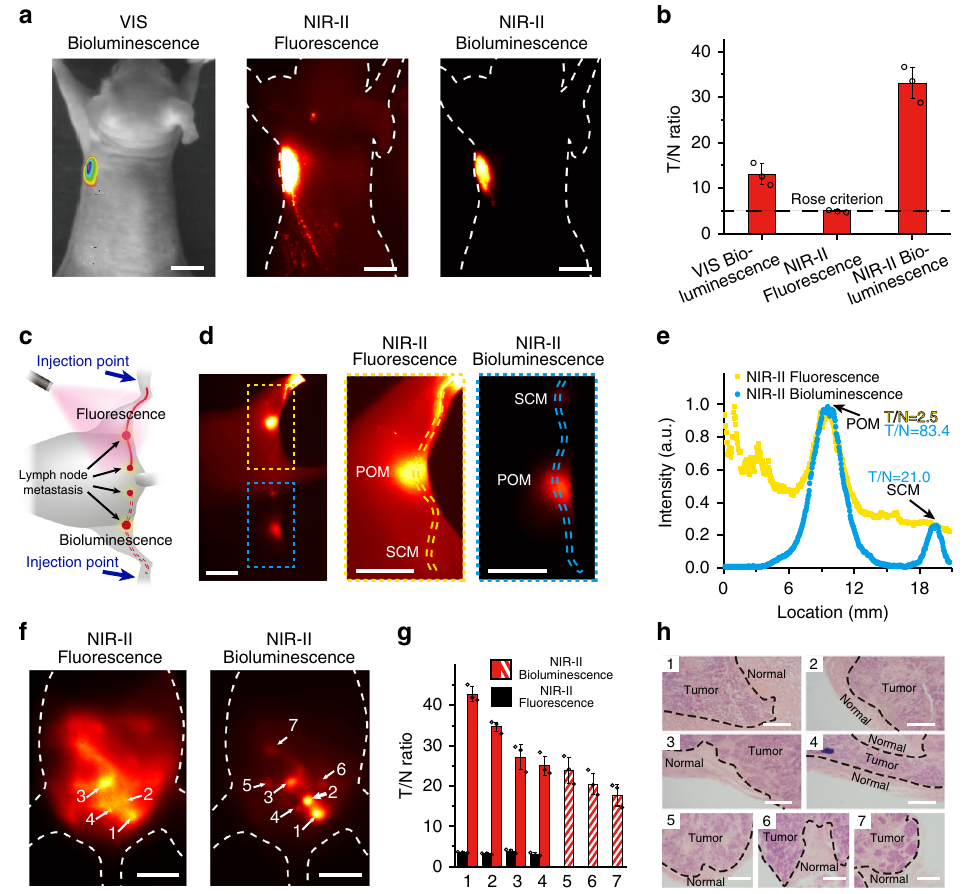
Fig. 7 ATP-mediated NIR-II-BPs for tumor and metastases imaging. a VIS bioluminescence imaging, NIR-II fl uorescence imaging and NIR-II bioluminescence imaging of the same tumor in a nude mouse. Scale bar, 1 cm. b T/N ratios of different optical imaging methods in a , black dashed line indicates the Rose criterion. Bars represent mean ± s.d. derived from n = 3 independent measurements. c Schematic illustration of executing fl uorescence imaging and bioluminescence imaging simultaneously on one nude mouse carrying lymph node metastases. Blue arrows indicate the subcutaneous injection location. d Fluorescence imaging (top) and bioluminescence imaging (bottom) of lymph node metastasis and the corresponding high- magni fi cation imaging (right). Scale bar, 5 mm. e Intensity pro fi les along the lymphatic vessels in d . f NIR-II fl uorescence imaging and NIR-II bioluminescence imaging of peritoneal metastases (No. 1 – 7) Scale bar, 1 cm. g T/N ratios of corresponding serial number tumors in f . Black dashed line indicates the Rose criterion. Bars represent mean ± s.d. derived from n = 3 independent measurements. h H&E staining results of metastatic tumors (No. 1 – 7) margin in f . All borderlines between early metastatic lesions and normal tissues can be observed. All the metastases were con fi rmed to be malignant and repeated for three times in independent experiments. Scale bars, 0.2 mm. Source data underlying b , e and g are provided as a Source Data fi